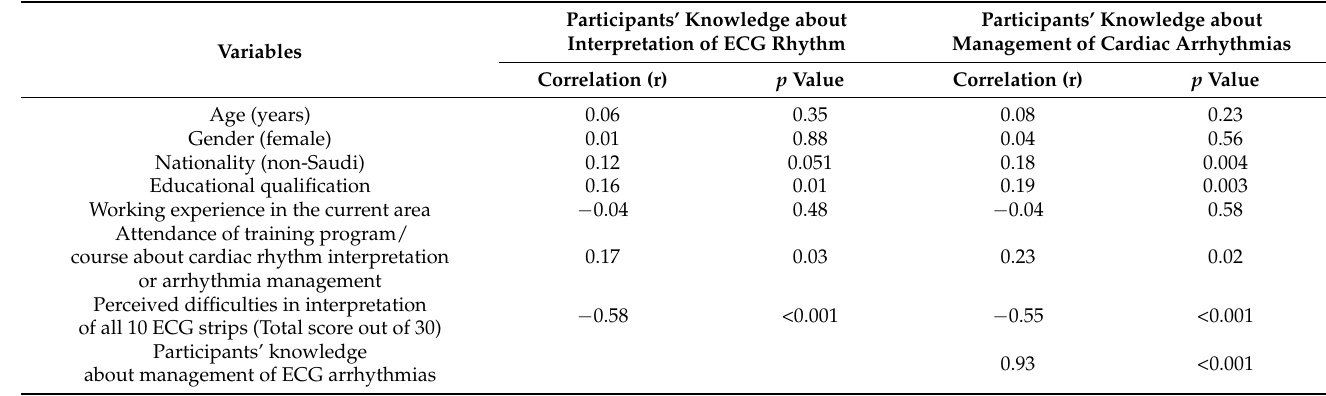
Table 6. Correlation between participants’ demographic characteristics, knowledge about manage- ment of ECG arrhythmias, and participants’ knowledge about interpretation of ECG strip